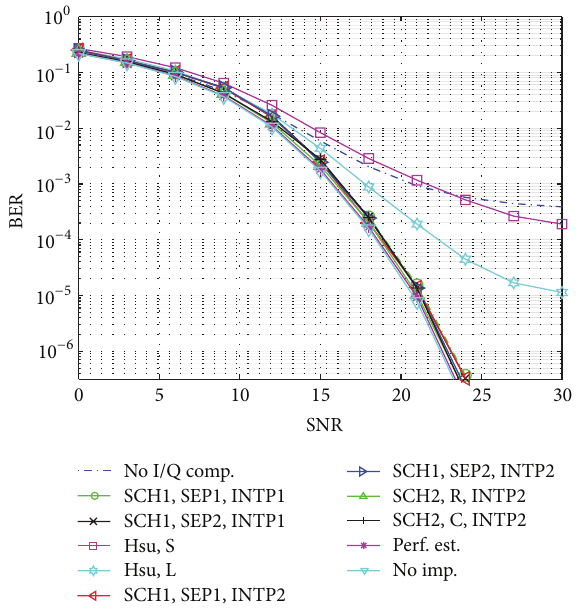
Figure 11: BER performance as a function of SNR, 𝑁 = = 91 512 and 𝑁 0